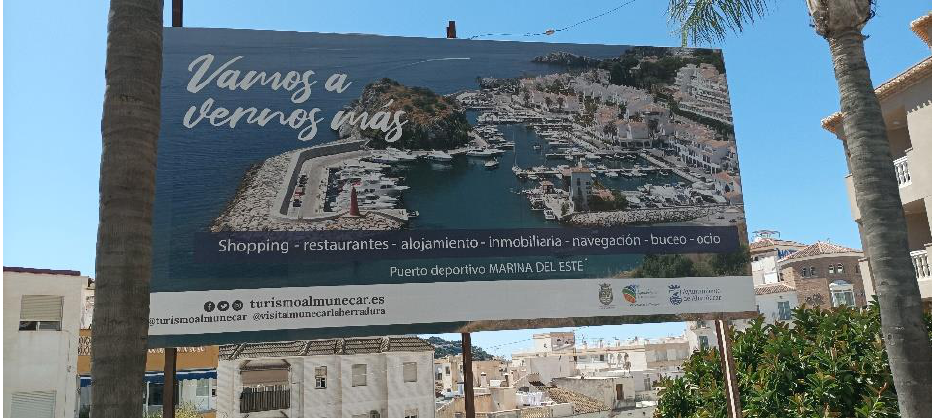
Figure 3. La Herradura tourist promotion advertising poster. Promoted by the Almuñécar Tourist